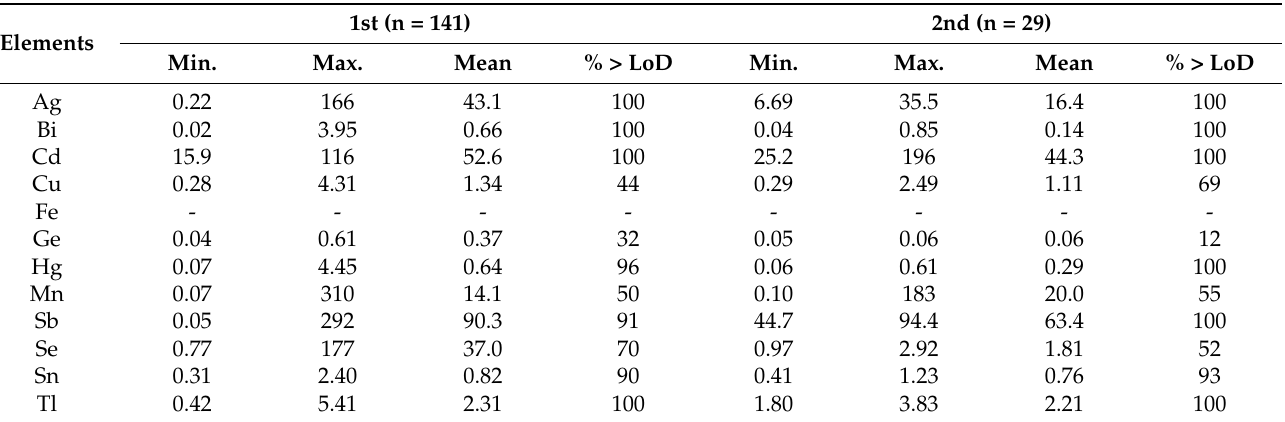
Table 5. Trace element contents of galena determined by LA-ICP-MS for the different generations. All units are in